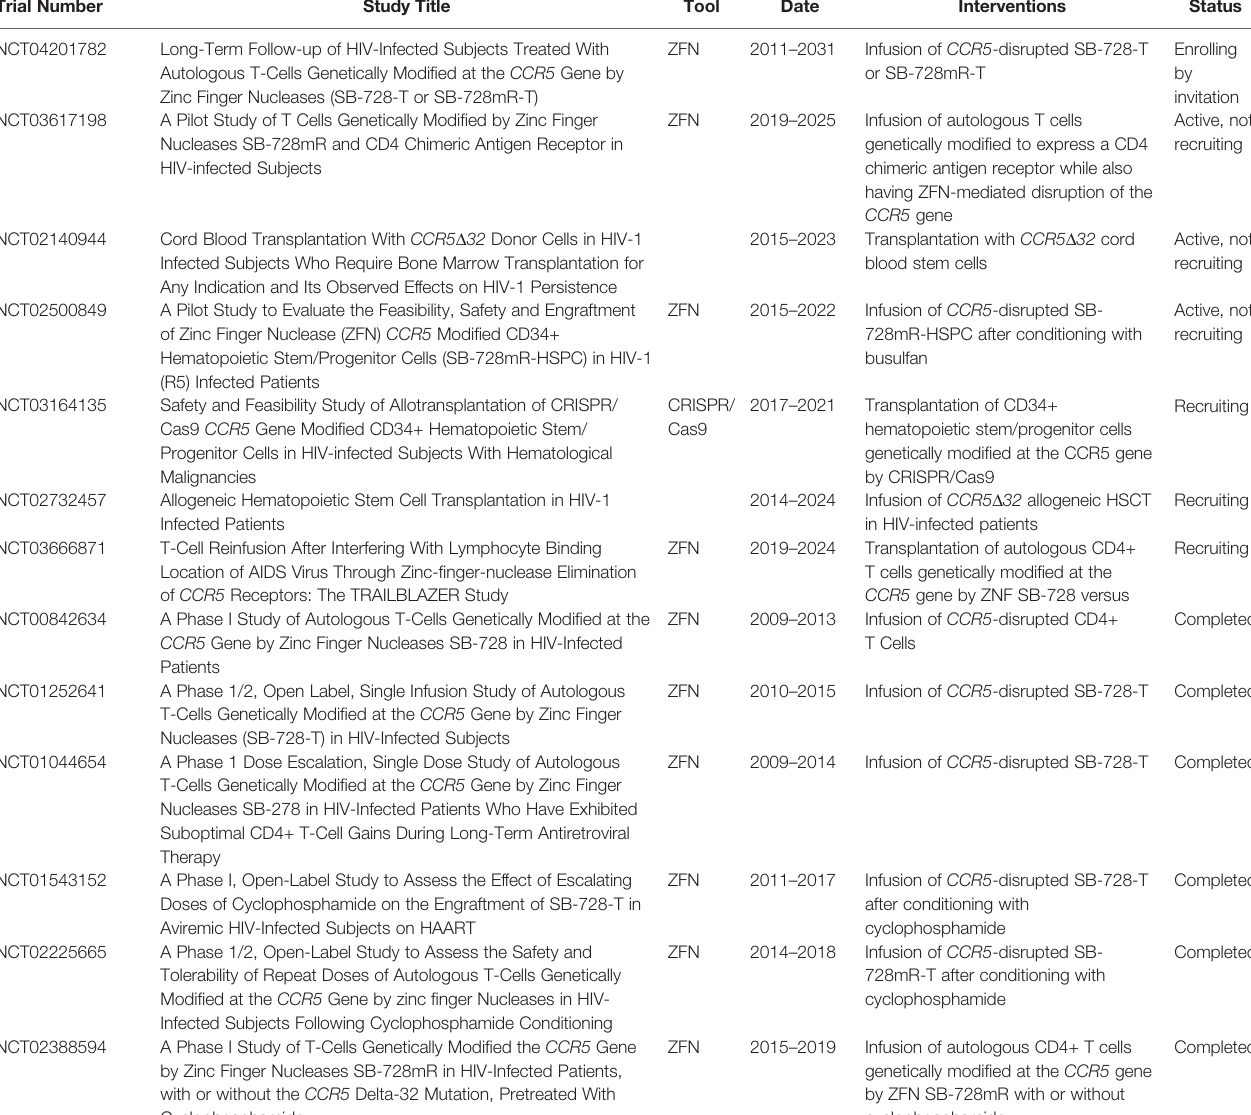
TABLE 2 | Clinical experiments of CCR5 -based stem/progenitor cell or T cell therapy for HIV-1